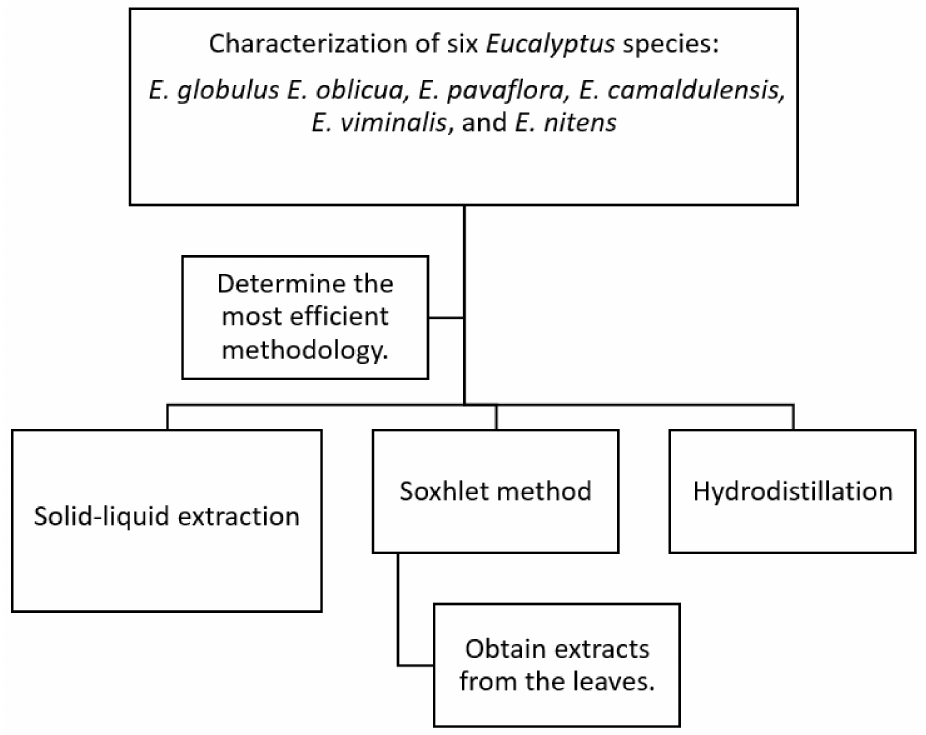
Figure 1. Flowchart of the proposed methodology.